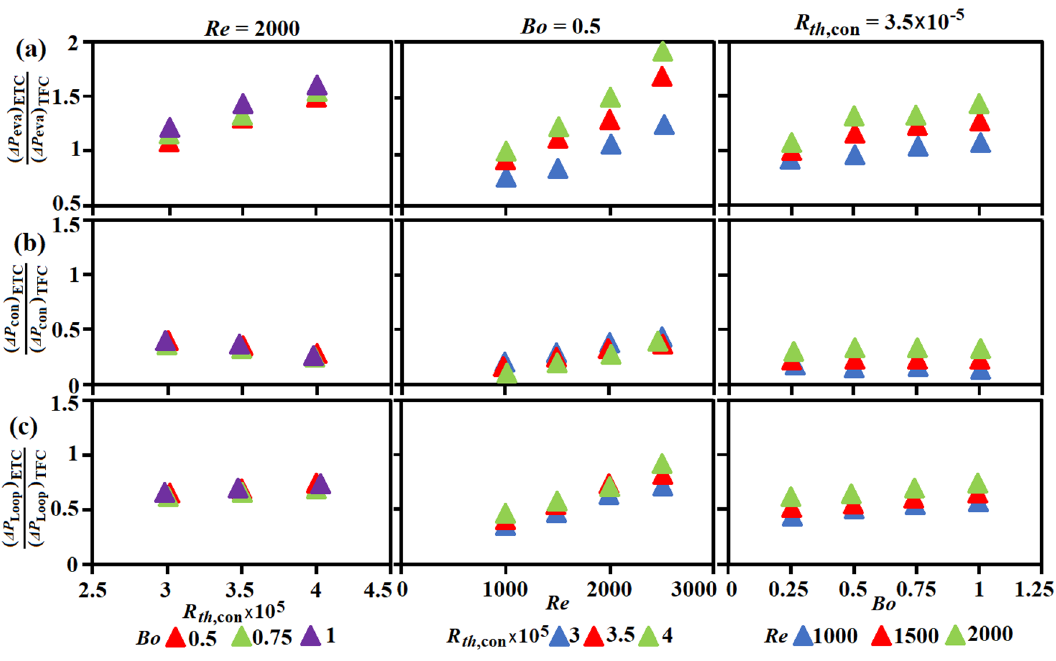
Figure 11. Variations of ( a ) ( Δ P eva ) ETC /( Δ P eva ) TFC ( b ) ( Δ P con ) ETC /( Δ P con ) TFC , and ( c ) ( Δ P Loop ) ETC /( Δ P Loop ) TFC against Bo , Re , and R th ,con .